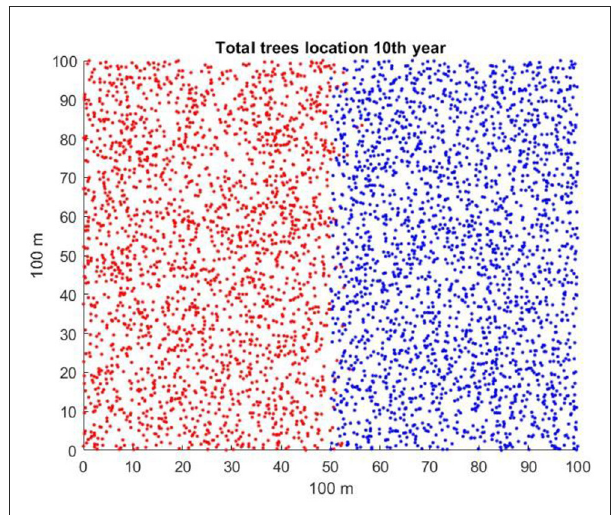
FIGURE1 Typical starting conditions for invader (red) occupying the left-hand side of the plot and native (blue) occupying the right-hand